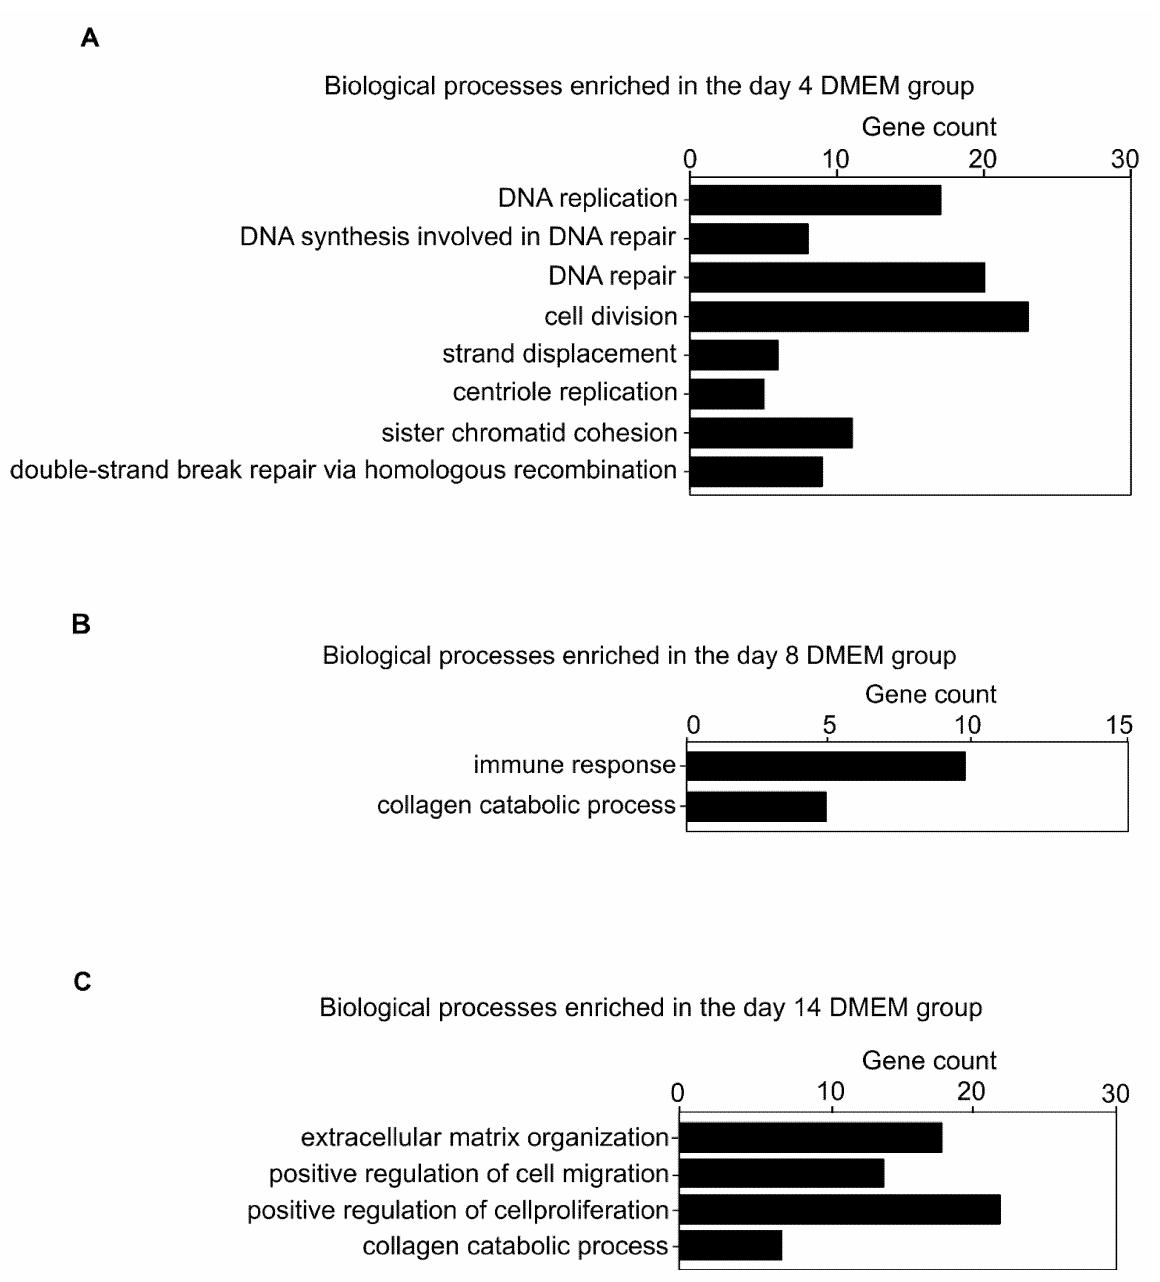
Figure 2. Global gene expression patterns during the production of the FPCL model. ( A ) GO terms on day 4. ( B ) GO terms on day 8. ( C ) GO terms on day 14. Abbreviations: FPCL, fibroblast-populated collagen lattice; GO, Gene Ontology; DNA, deoxyribonucleic acid; DMEM, Dulbecco’s modified Eagle’s medium; ECM, extracellular matrix.